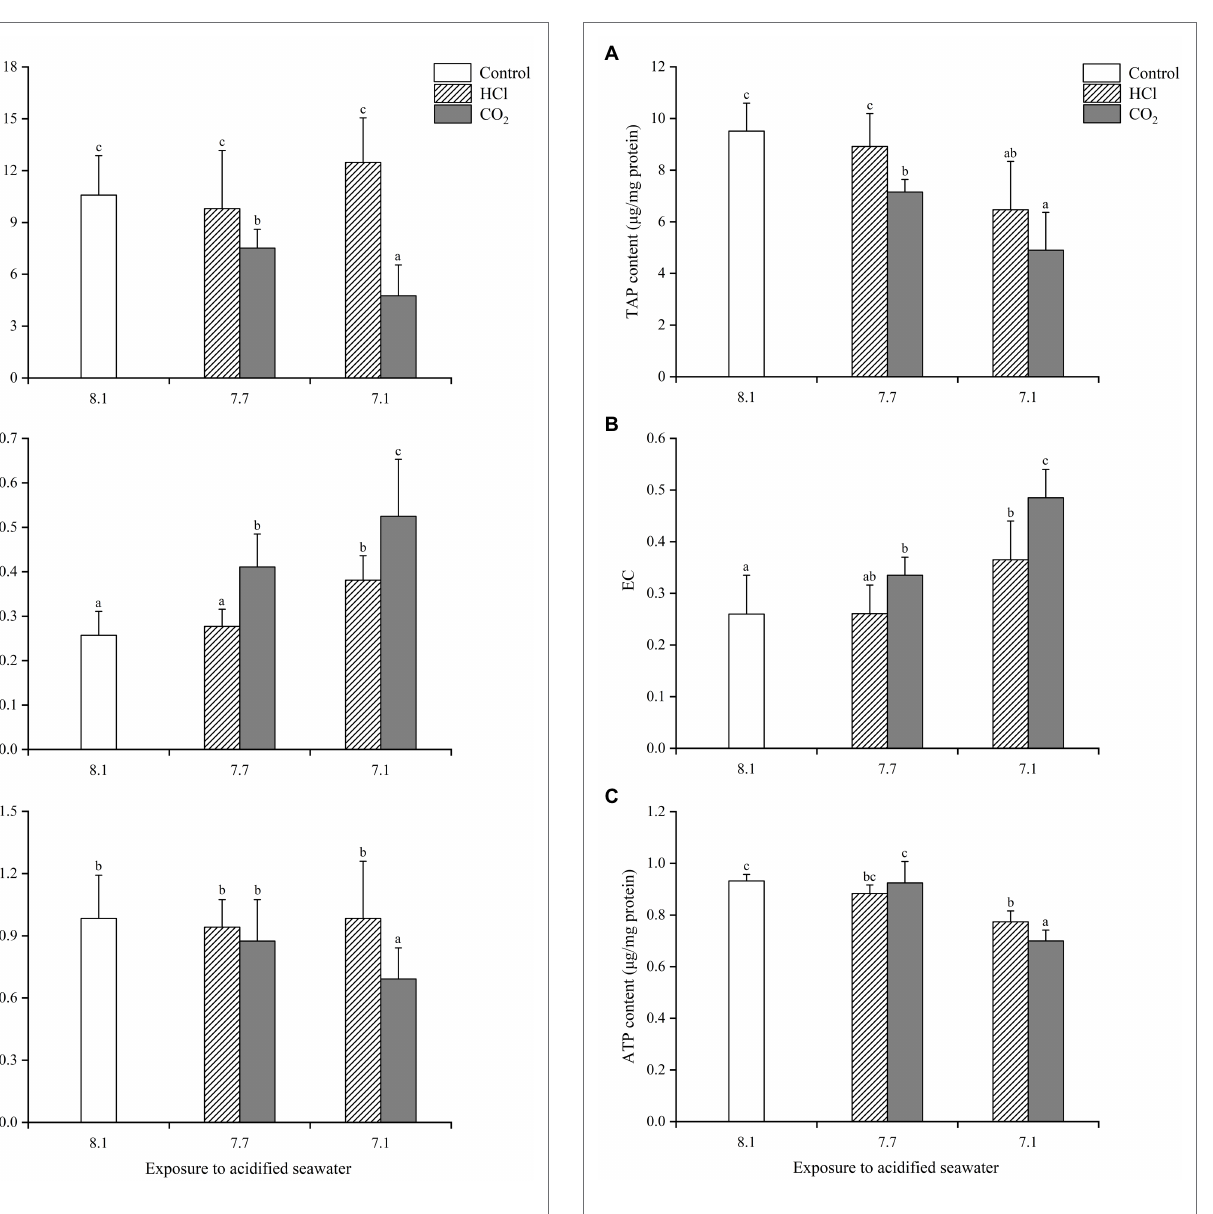
FIGURE 1 | Effects of seawater acidification induced by HCl addition and CO 2 enrichment on TAP content (A) , EC (B) and ATP content (C) in gills of Mytilus edulis . Data were expressed as means ± SD ( n = 6). Different letters represent significant differences among experimental groups ( p <